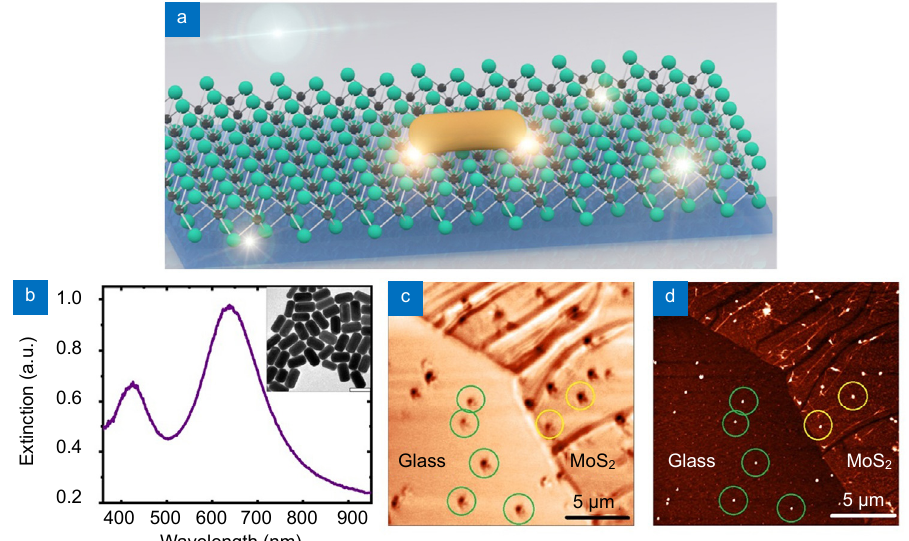
Fig. 1 | ( a ) Schematic diagram of GNRs-MoS 2 hybrid on the glass substrate. ( b ) Extinction spectra of GNRs in aqueous solution. Inset: transmis- sion electron micrographs of the GNRs with a scale bar of 100 nm. ( c ), ( d ) Optical confocal scanning image and AFM image of the GNRs-MoS 2 , respectively. The green and yellow circles indicate the positions of single GNR on glass and MoS 2 monolayer, respectively, with a scale bar of 5 μ